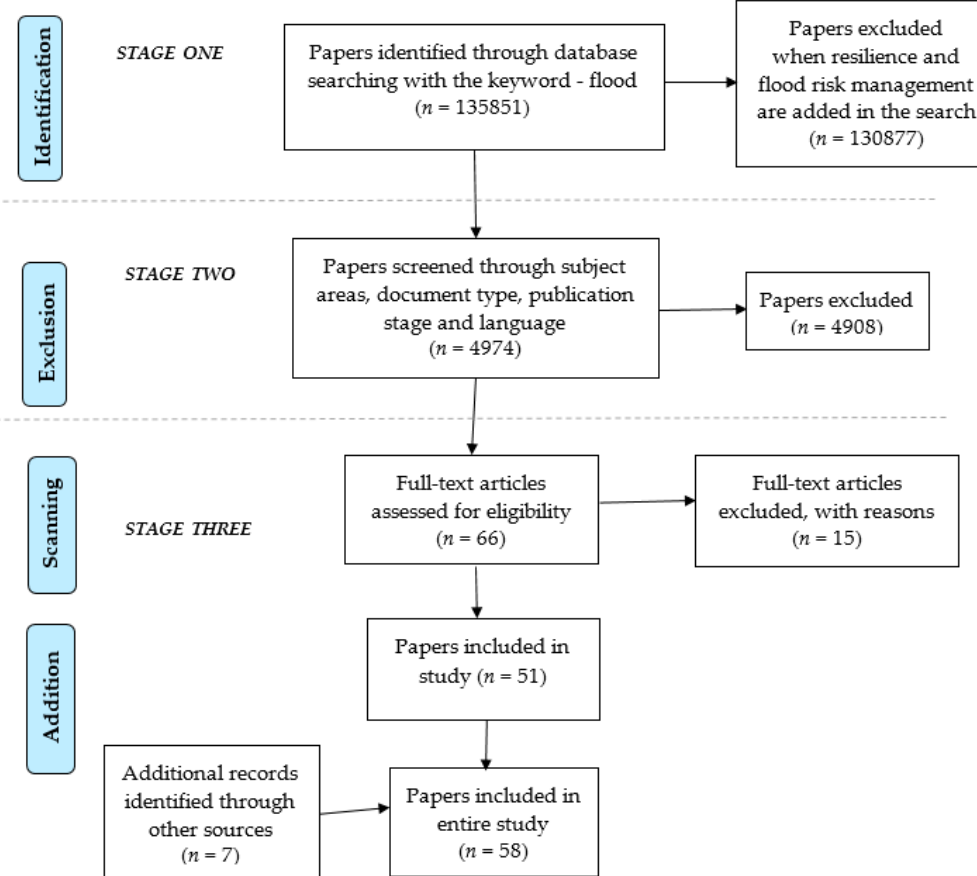
Figure 3. The flow diagram of the Systematic Literature Review (SLR) for the paper selection.